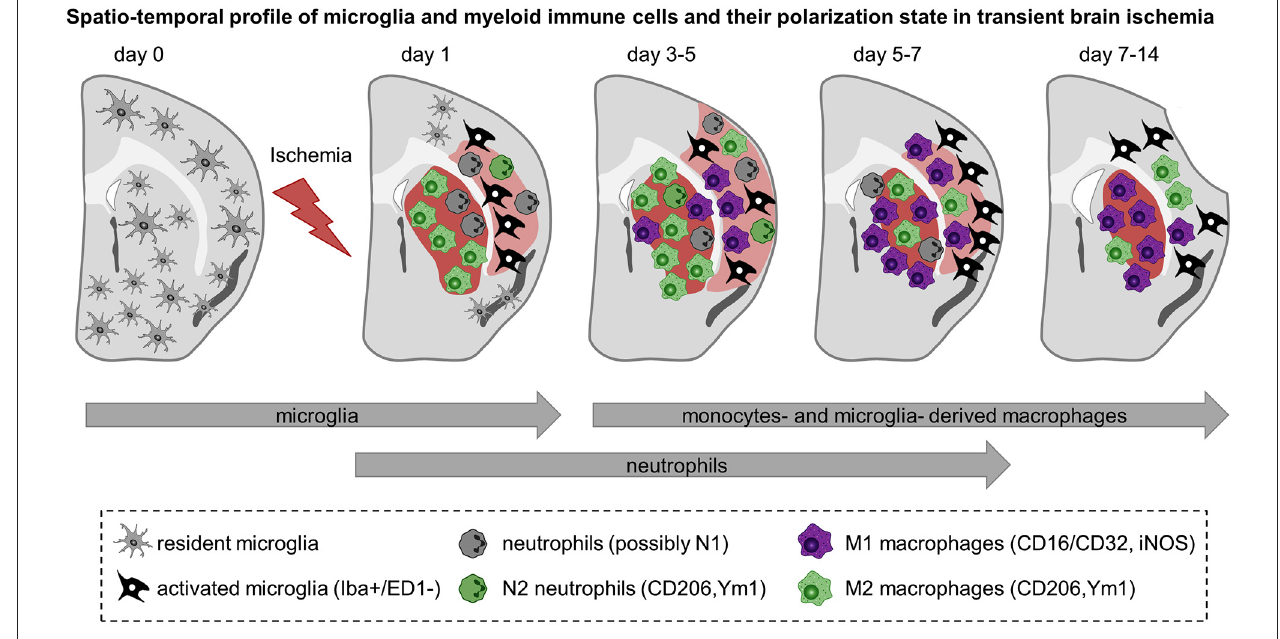
cellular debris and clear the damaged tissue. In the peri-infarct region microglia have ramified processes but are negative for the phagocytic marker ED-1. They are present early after injury, peak between 5–7 days and decrease thereafter. Neutrophils are the first myeloid immune cells to invade the brain and might display a N1 or N2 phenotypes. They can be detected in the ischemic region from 1 to 5–7 days after injury. Monocytes infiltrate the ischemic parenchyma after microglia activation and transform into macrophages. Between 3–5 days M2 macrophages are more abundant in the striatum—the core of the infarct—and decline by 2 weeks. In contrast, pro-inflammatory M1 cells are first observed in the peri-infarct of the lesion and increase in number in the core over time and outnumber the M2 macrophages later on. From 3–5 days onwards it is not clear yet whether the so called M1 and M2 macrophages found in the ischemic region are derived preferentially from microglia or infiltrated monocytes and if they have similar functions. Preliminary data suggest that microglia-derived macrophages can proliferate and have greater phagocytic properties than monocytes-derived